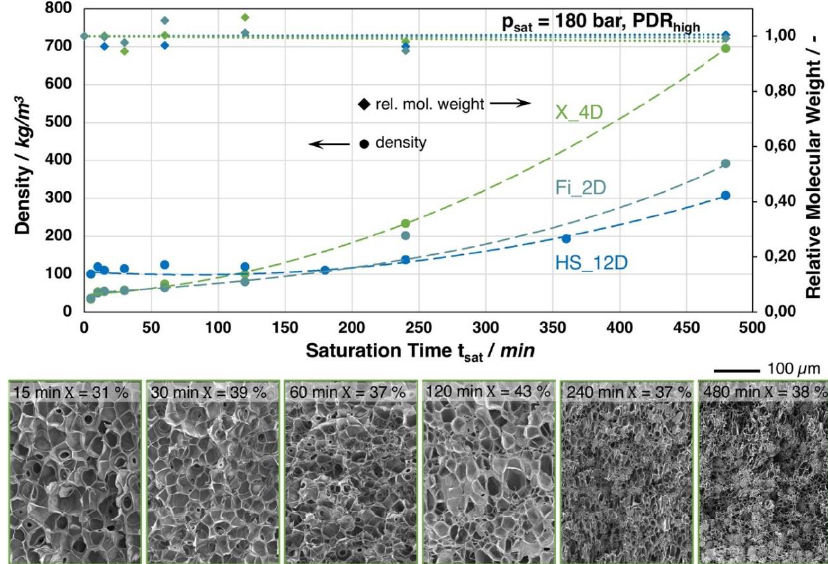
Figure 9. Top: Foam densities of the grades Fi_2D, X_4D, and HS_12D (with similar molecular weight but varying D-contents) foamed with CO 2 at 180 bar and varied saturation times. Bottom: SEM images of the X_4D foam with different saturation times and crystallinity values (1 st heating, 10 K/min.).